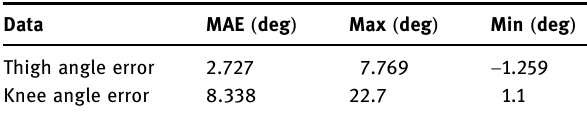
Table 3: Performance results of thigh and knee